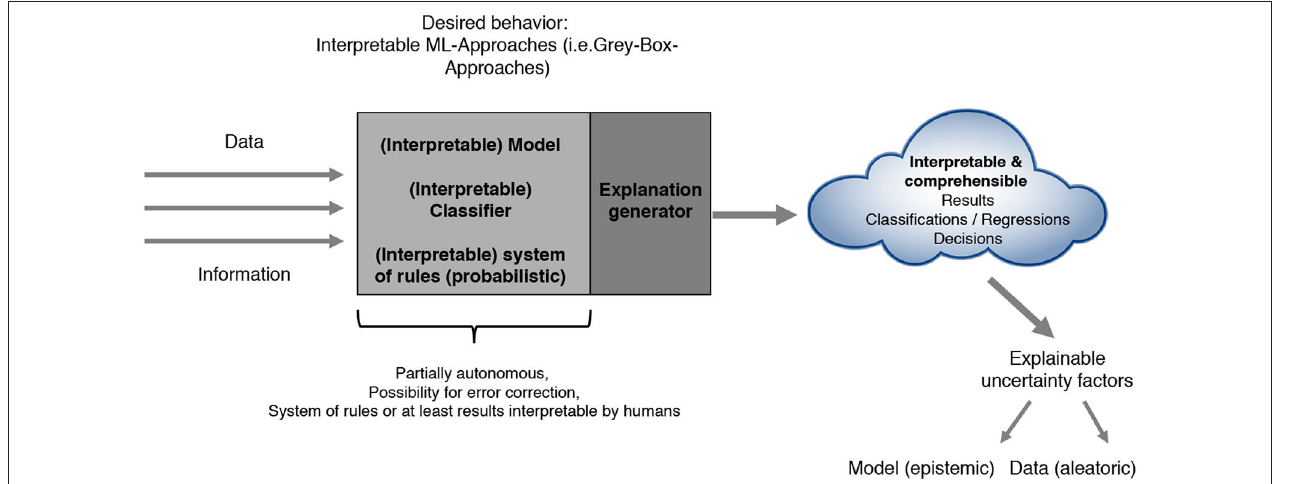
FIGURE 2 | Future comprehensible ML-approaches (i.e., gray-box